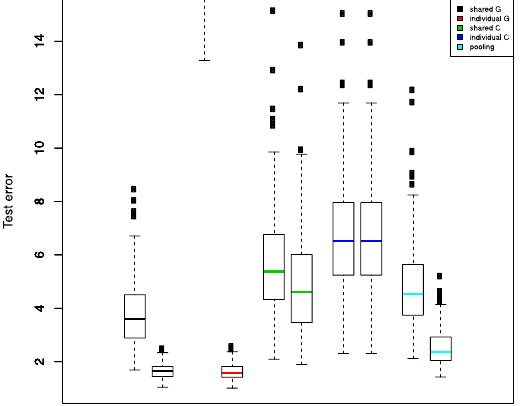
Figure 2. Simulation test set error boxplot pairs by analysis method. Left hand member of the pair represents a training set sample size of 100 and the right hand member, a training set sample size of 400. Test set sample sizes are always set a 300. Black represents predictions generated by using β ˆ only estimated from the data sharing model across G and C; red represents predictions generated from a model using only dataset G; green represents predictions using β δ + ˆ ˆ only from the data sharing model across G and C; blue represents predictions generated from a model using only dataset C; and finally light blue, predictions from a model pooling datasets G and